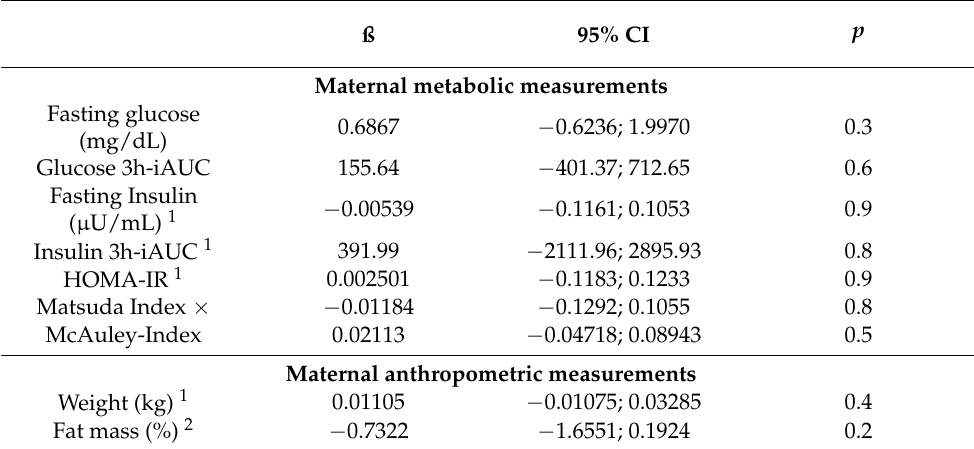
Models contain a random statement with an unstructured covariance structure. Model a contains time (defined as duration in weeks between the baseline and final visit), mean glycemic load during the study (adjusted for energy using the residual method), fixed effects of intervention group, and BMI at study baseline. 1 logarithmized to achieve normal distribution. 2 measured in the Bod Pod and calculated using the Van Raiij formula.